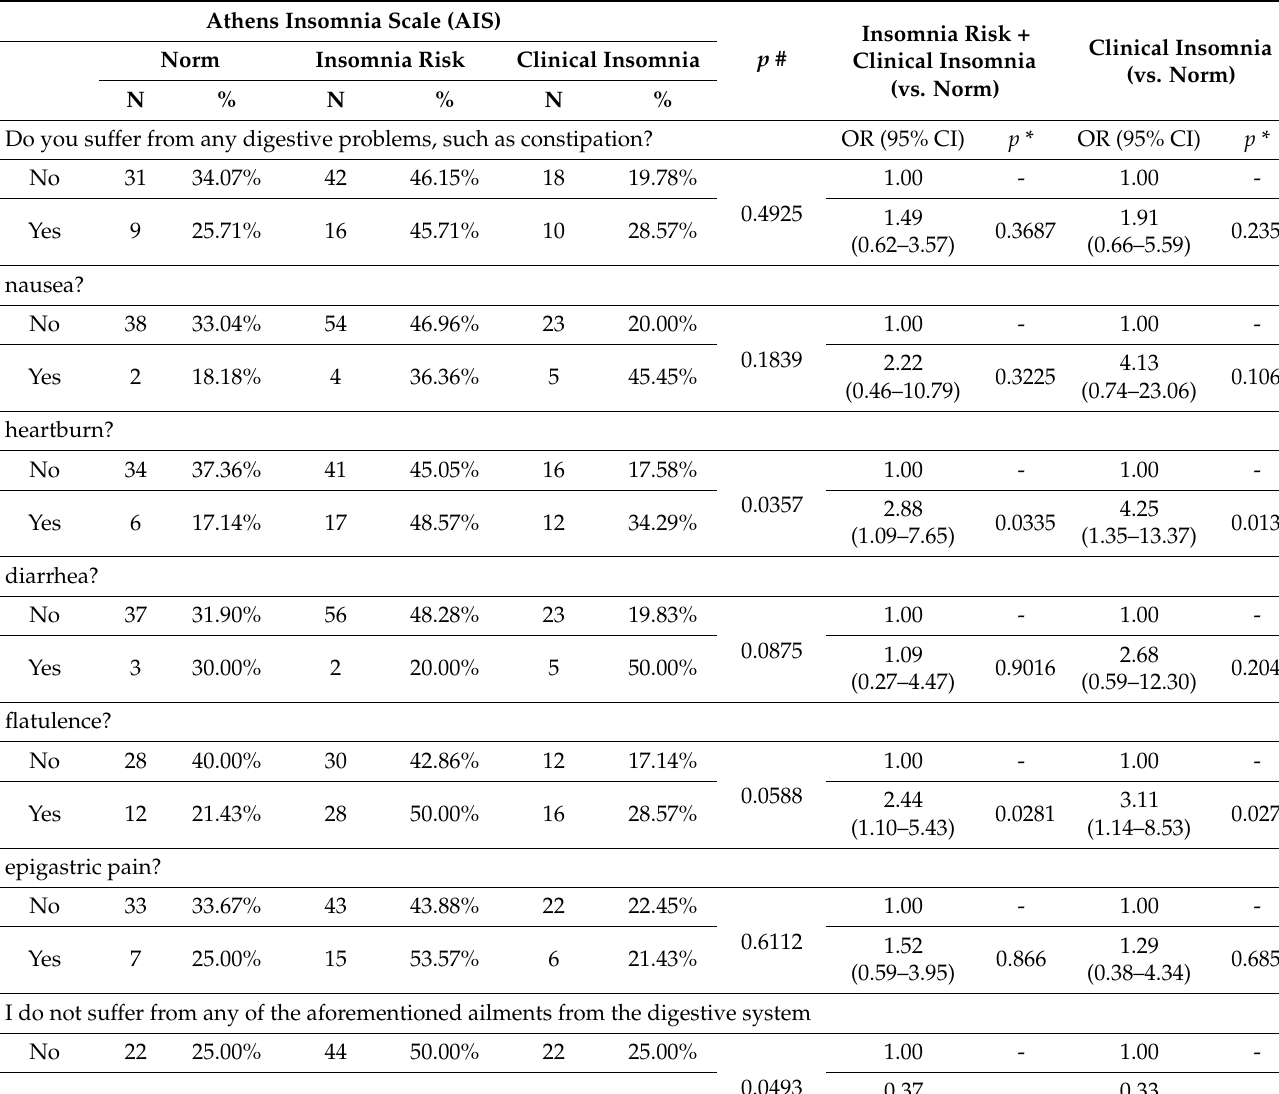
Table 5. Disorders of the gastrointestinal tract and the occurrence of sleep